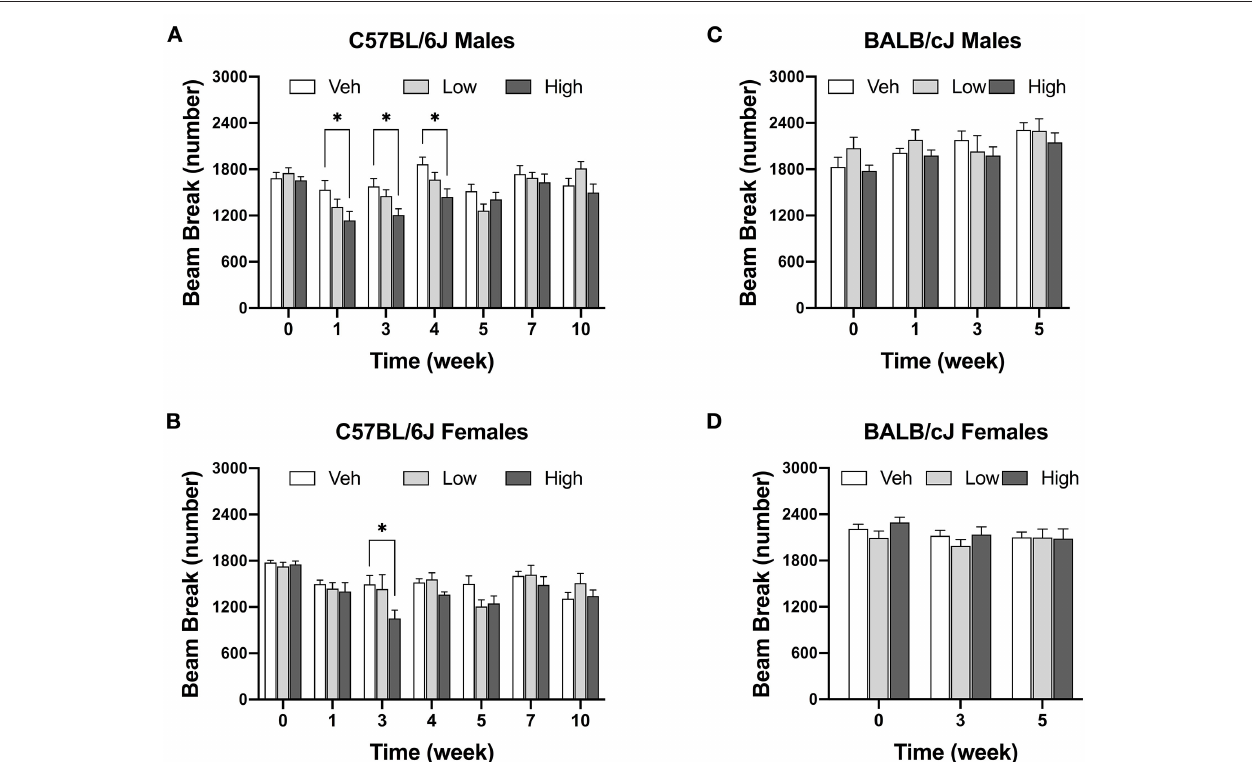
FIGURE 4 | High dose of oxaliplatin reduce spontaneous locomotor activity in C57BL/6J mice. One regimen of the high dose of oxaliplatin was sufficient to reduce locomotor activity in C57BL/6J males ( n = 8–10/group) (A) which continued 1 week after the treatment. C57BL/6J females ( n = 6–8/group). (B) showed lower activity after two regimens. No alteration in motor coordination was obsessed in BALB/cJ males ( n = 7–9/group) (C) nor females ( n = 10/group) (D) . Overall effects of oxaliplatin treatment were identified by two-way or mixed-analysis model ANOVA (Treatment, Time as RM) for each strain and for each sex with post-hoc Tukey’s multiple comparisons test, * p <